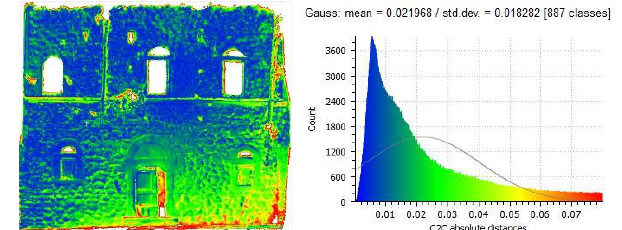
Figure 10: (a) Comparison between Dense Point Clouds from